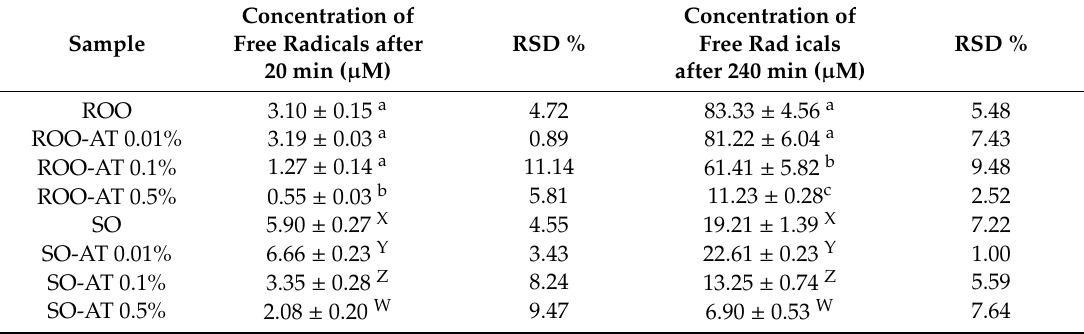
Table 4. Results of ESR-forced oxidation assay after 20 min and 240 min for refined olive oil (ROO) and sunflower oil (SO) with α -tocopherol (AT) added. Data are presented as mean ± standard deviation and coe ffi cient of variation (RSD